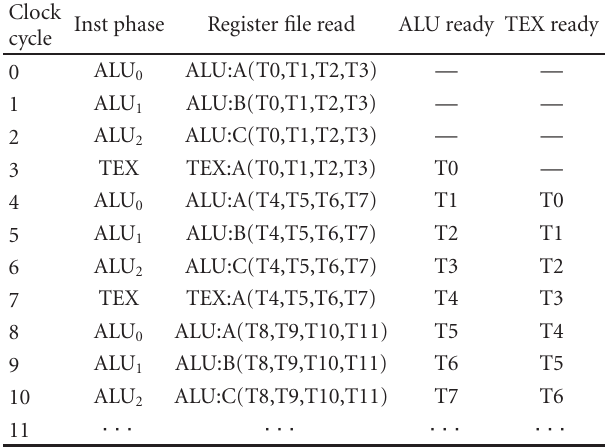
Table 2: The schedule of operand reads from the central register file for batches of four threads (T0–T3, T4–T7, etc.) decoding both ALU and TEX instructions. TEX instructions require only one